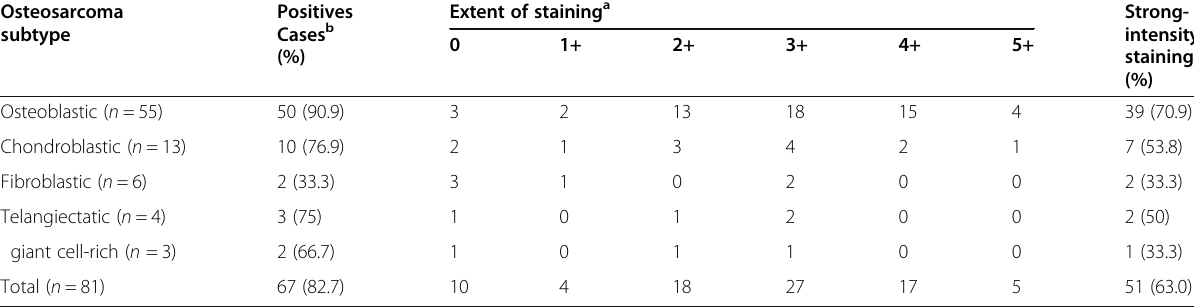
Table 3 Expression and extent of KPNA2 Immunohistochemical staining in osteosarcoma subtypes Osteosarcoma